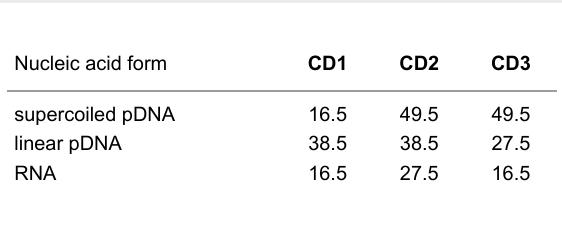
Table 2: Minimum N/P ratios for complete binding of different forms of nucleic